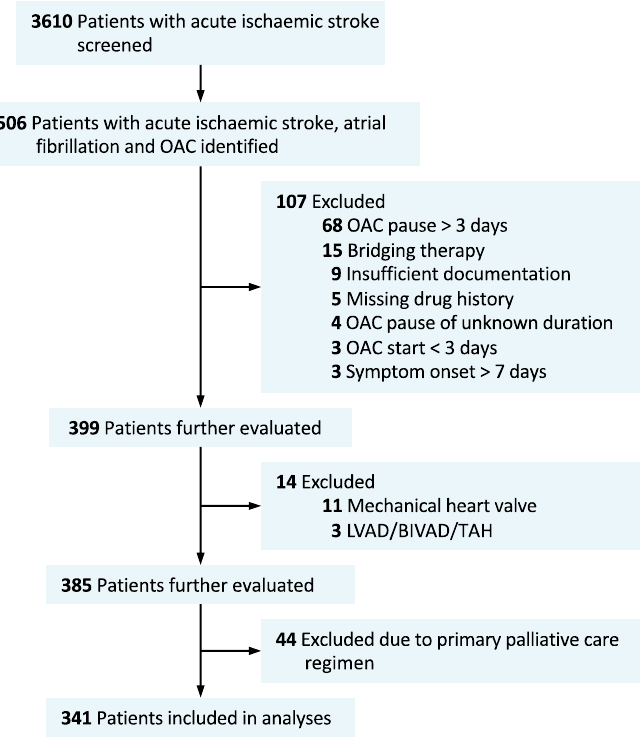
Figure 1. Flow chart of study population. OAC, oral anticoagulation; LVAD, left ventricular assist device; BIVAD, biventricular assist device; TAH, total artificial heart. Table 1. Patients and case characteristics ( n = 341).